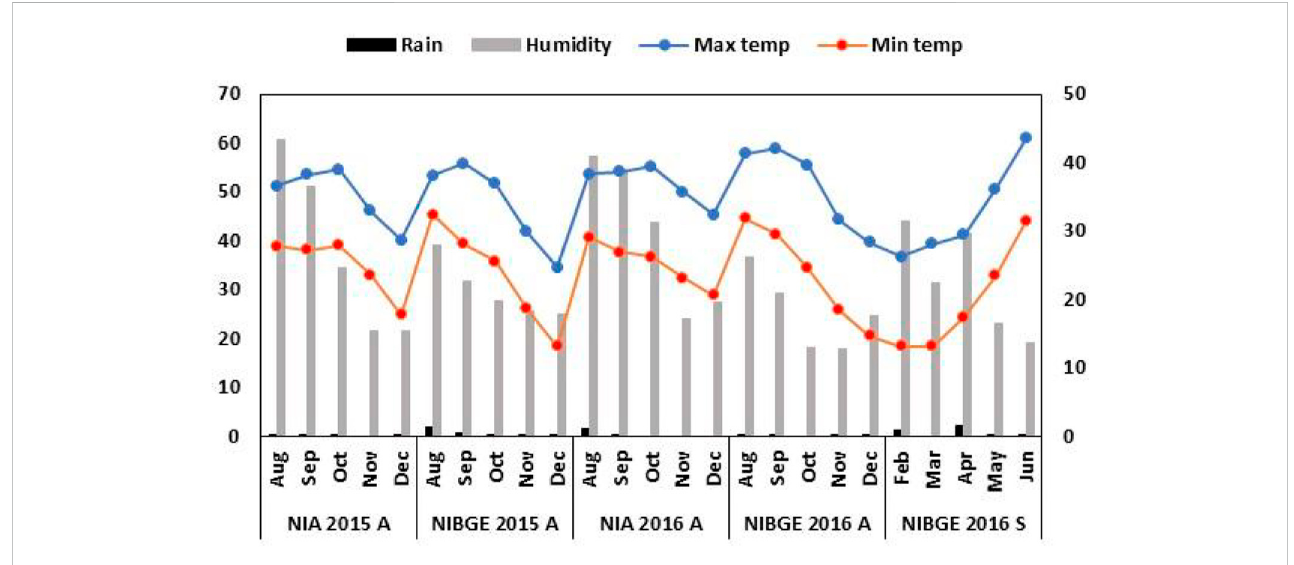
FIGURE 1 Weather footprint for the soybean genotypes ’ growth period. Monthly rainfall (mm) (left x-axis) and relative humidity (%) (right